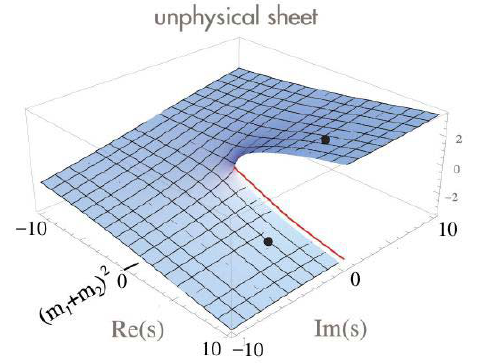
Figure 1. The imaginary part of a single-channel amplitude in the presence of a resonance. The solid dots indicate the allowed positions for resonance poles. Figure from